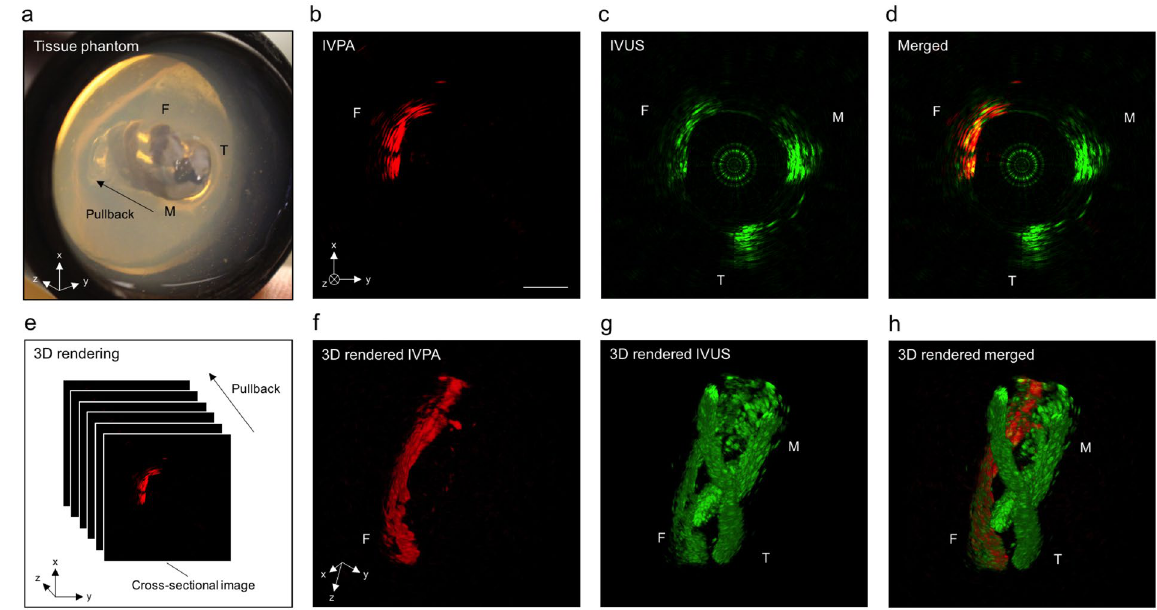
Figure 6. IVPA-US imaging of tissue phantom at 16 fps. ( a ) Picture of tissue phantom. F, intramuscular fat; T, tendon; M, muscle. Cross-sectional ( b ) IVPA, ( c ) IVUS, and ( d ) merged images of the tissue phantom. The scale bar and the coordinates in ( b ) is also applied to ( c , d ). ( e ) 3-D rendering method. 3-D rendered ( f ) IVPA, ( g ) IVUS, and ( h ) merged images of the tissue phantom with a pullback length of 10 mm. The coordinates in ( f ) is also applied to ( g , h ). Scale bar: 1